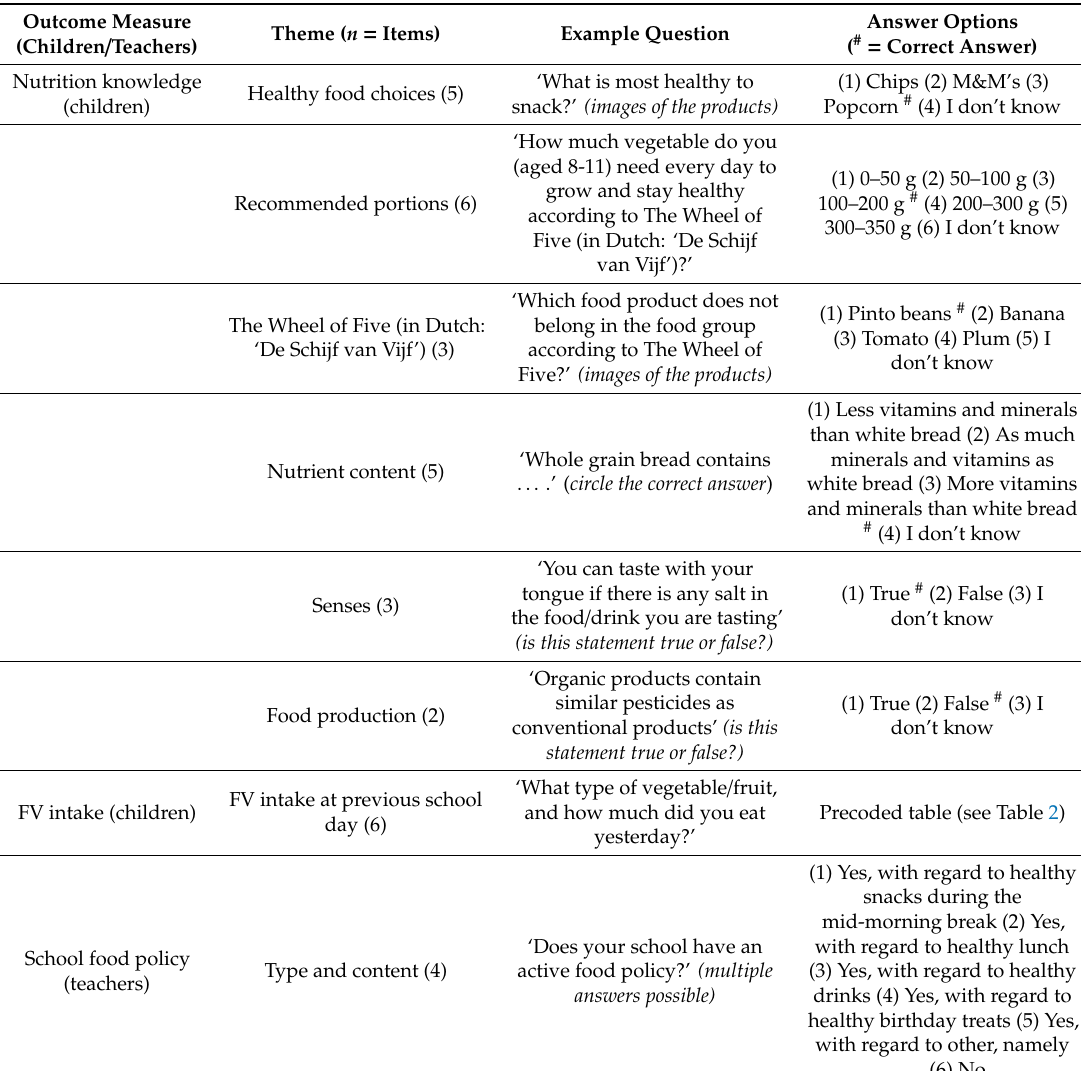
Table 1. Items used to measure nutrition knowledge and FV intake (children) and food policies in school (teachers)